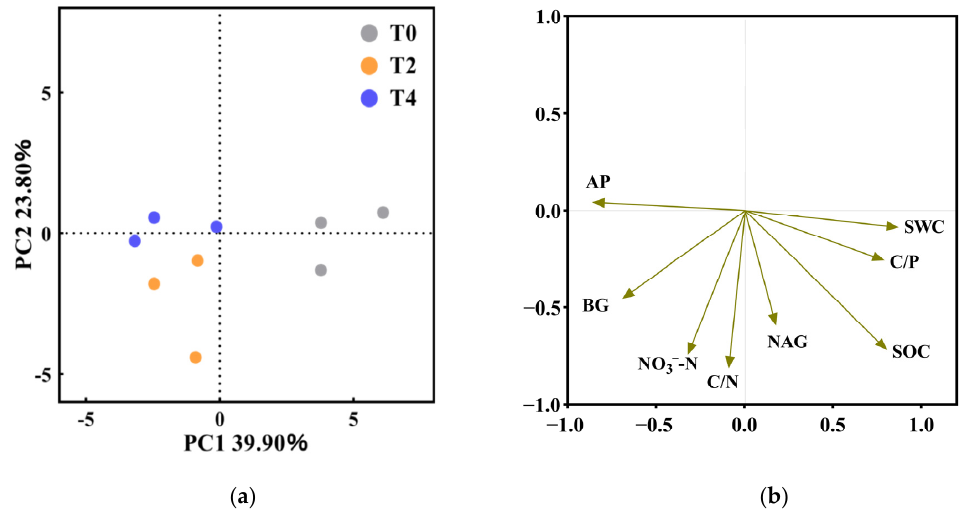
Figure 4. Principal component analysis (PCA) of soil and enzyme activity factors under different treatments. T0: control without warming; T2: 2 °C warming treatment; T4: 4 °C warming treatment. ( a ) Different colors represent different treatments, the farther the distance between points represents the greater the sample difference; (b) According to the quality of variables in principal component analysis, eight variables with greater contribution were selected.